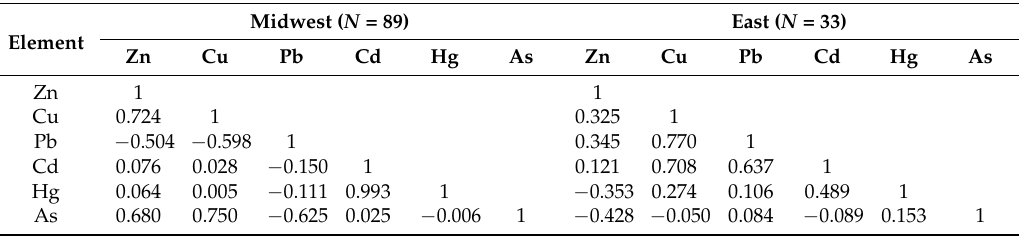
Table 5. The Pearson’s correlation coefficient ( r ) between six toxic elements ( N = 122).